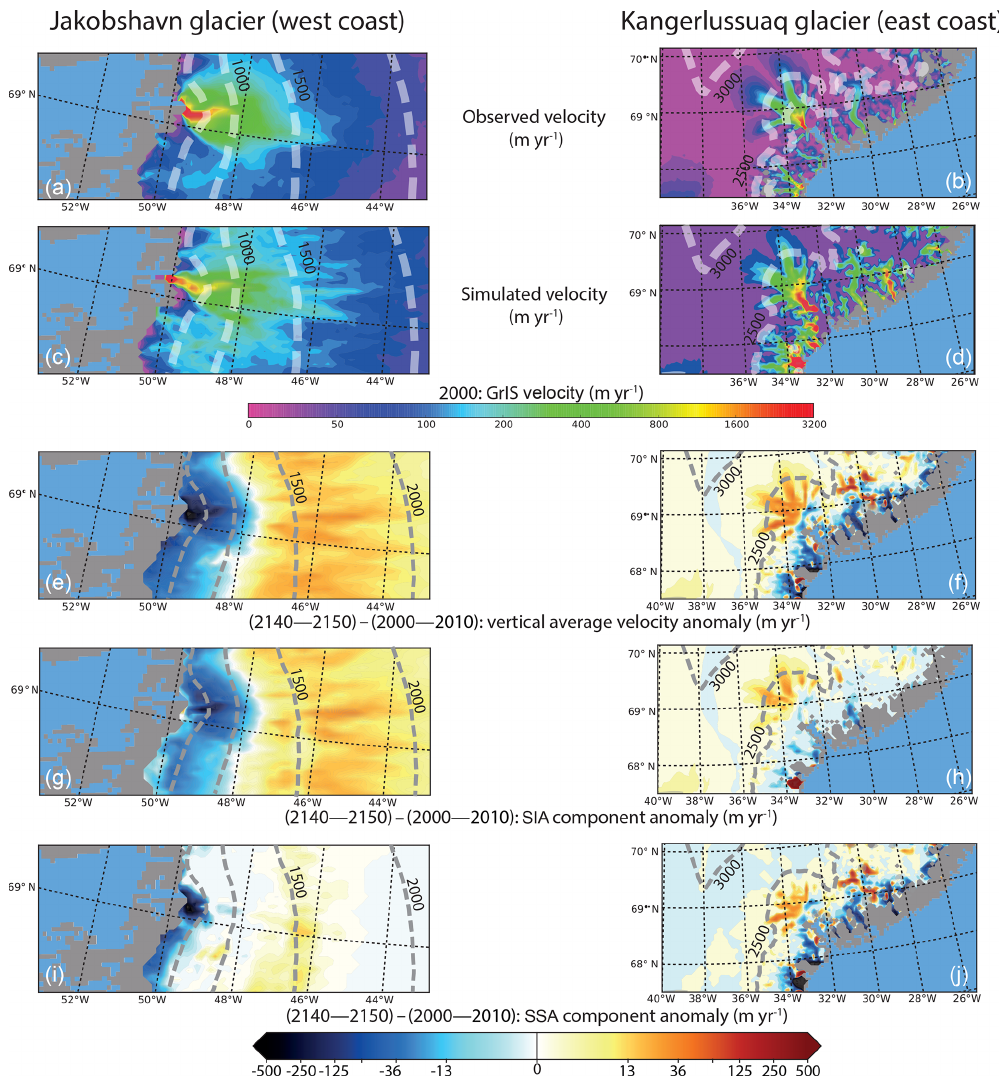
Figure 7. Regional zoom over the Jakobshavn (left panels) and the Kangerlussuaq (right panels) glaciers for the 2W experiment. Panels (a) and (b) are the observed velocities (in myr − 1 ) from Joughin et al. (2018). Panels (c) and (d) are the simulated velocity (in myr − 1 ) after the initialization procedure. Panels (e) to (j) represent the velocity anomalies (in myr − 1 ) between the 2140–2150 and the 2000–2010 mean periods of the 2W experiment for the vertically averaged surface velocity ( e and f ), the SIA velocity component ( g and h ) and the SSA velocity component ( i and j ). Note that a logarithmic scale is used for the velocity anomalies. The dashed lines correspond to the 500m surface elevation iso-contours for the present-day observed topography. The grey shading represents the non-ice-covered areas and the blue shading is the ocean